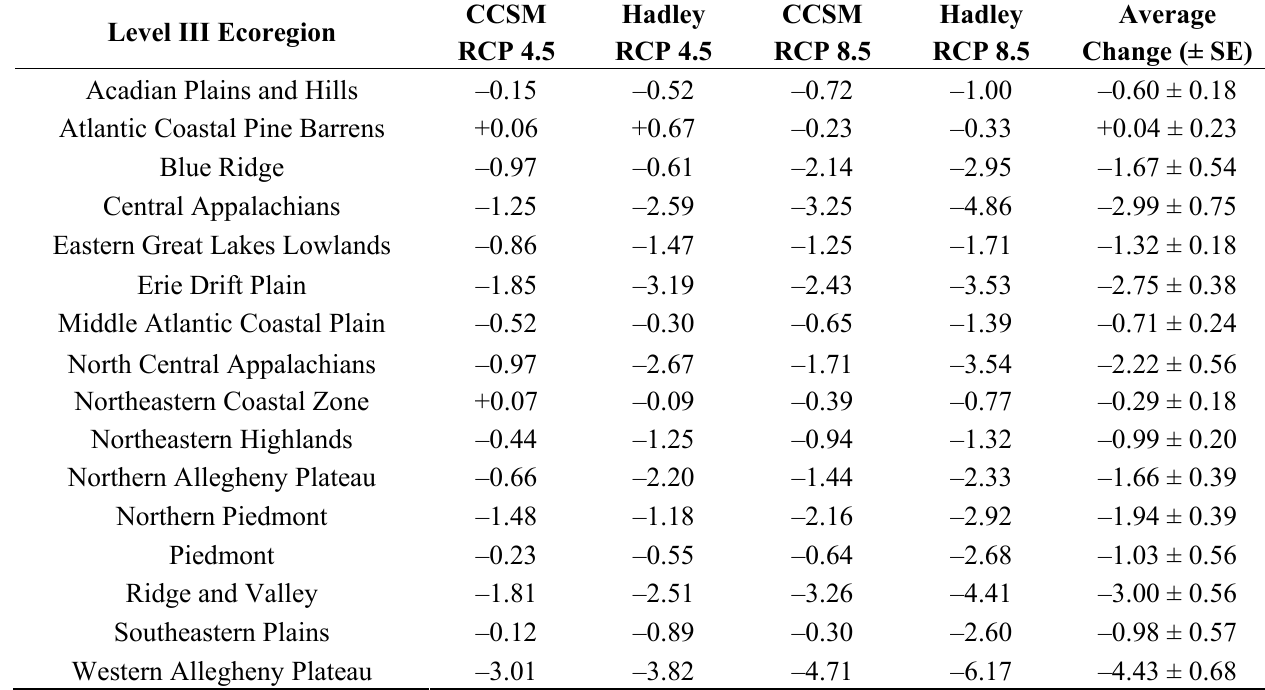
Table 2. Mean change in climate refugia richness ( i.e. , number of salamander species with a climatically-suitable niche in a landscape patch) within U.S. EPA Level III ecoregion of the northeastern U.S. (Figure 1) based on 2050 projected climatic scenarios (CCSM4 (CCSM) and HadGEM2-CC (Hadley)) and two Representative Concentration Pathways (RCP 4.5 and 8.5). Negative numbers indicate a decrease in the average number of priority salamander species for which an ecoregion provides suitable climatic